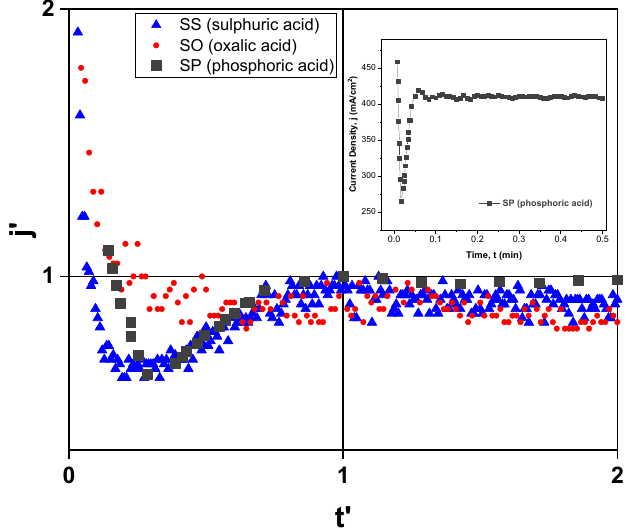
Figure 5. The ordinate and abscissa axes were normalized using the transformations j (cid:48) = j / j max and t (cid:48) = t / t max , where j max and t max are the current density (mA/cm 2 ) and time (min) maximum values, respectively. Different values of ( t max ; j max ) were found for each electrolyte, namely (1.14 min; 36.5 mA/cm 2 ) in sulfuric, (0.37 min; 26.2 mA/cm 2 ) in oxalic and (3.6 s; 418.5 mA/cm 2 ) in phosphoric acid. The inset shows the curve of current density vs. time of SP sample (anodized in phosphoric acid)—without